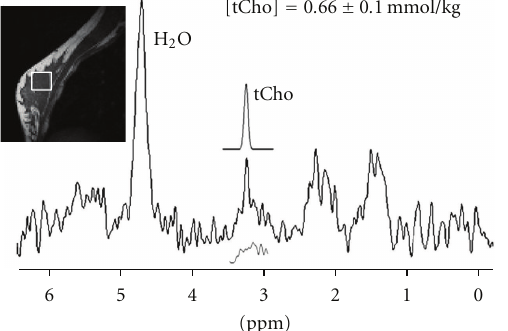
Figure 3: MRI and MRS measurement in a patient with false- positive benign lesion. This patient showed dense glandular tissues on the sagittal precontrast image and mild enhancement on the enhanced MR image. The spectroscopic voxel size was 2 × 2 × 2cm 3 . The elevated tCho peak at 3.2 ppm is clearly visible in the water-fat suppressed spectrum. The Gaussian model fitting of the tCho peak yields a measurement of [tCho] = 0.66 ± 0.10 mmol/kg, the estimated model fit is shown above the full spectrum, and the residue is shown underneath.